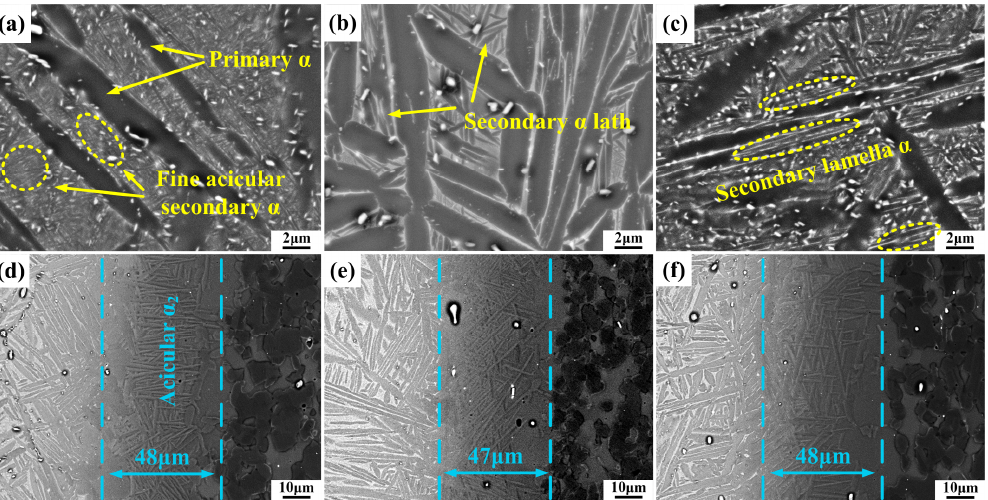
Figure 5. The microstructure of heat-treated composites: ( a ) DsTi700 alloy and ( d ) interfacial region of HT2; ( b ) DsTi700 alloy and ( e ) interfacial region of HT3; ( c ) DsTi700 alloy and ( f ) interfacial region of HT4.